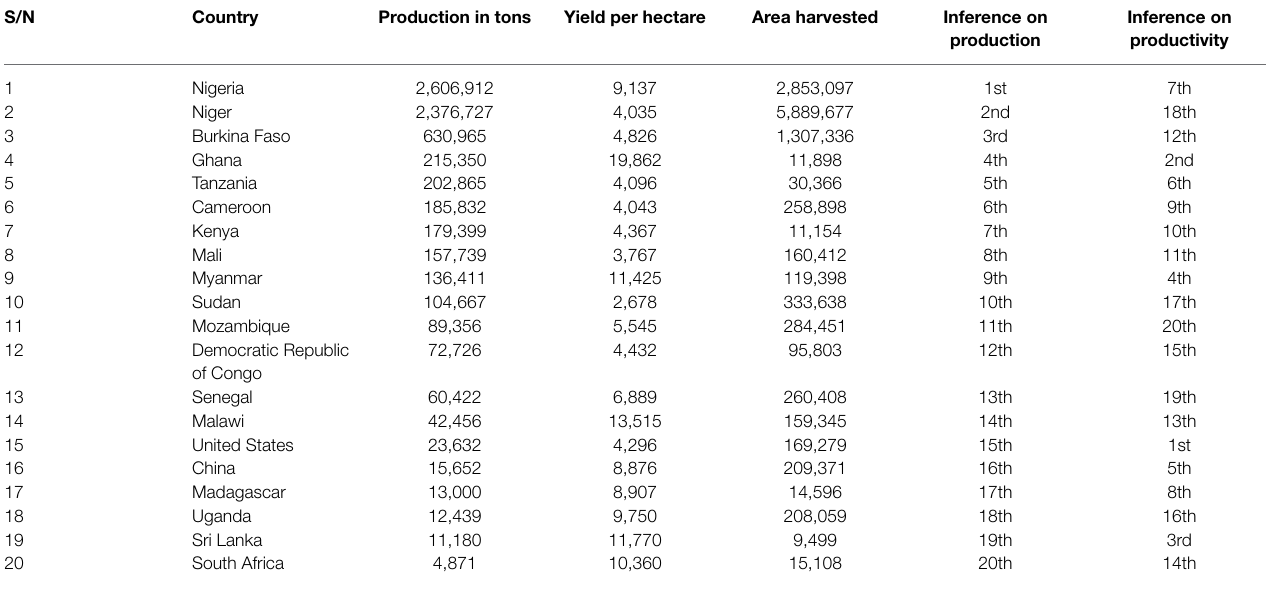
TABLE 1 | Production output and productivity of cowpea by some selected countries in the world, excluding Brazil as (adapted from Faostat, 2020). S/N Country Production in tons Yield per hectare Area harvested